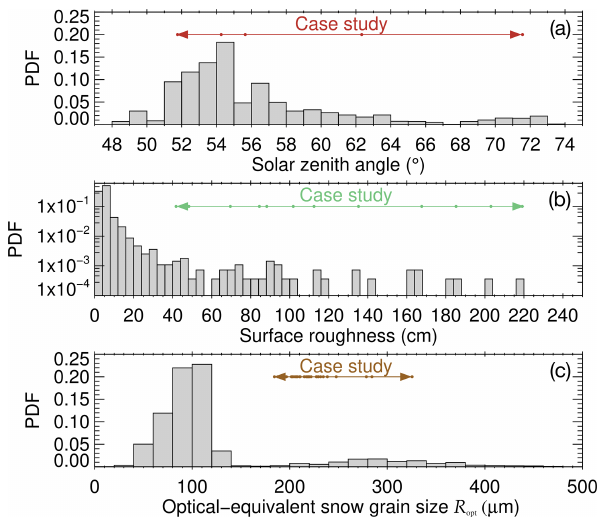
Figure 2. Variability of different parameters during research flights shown as histograms of the probability density function (PDF). The parameter ranges covered by the case studies are marked with the same colors as the corresponding flight tracks in Fig. 1. (a) Vari- ability of solar zenith angle (bin size: 1 ◦ ). (b) Variability of surface roughness (bin size: 4cm). Note the logarithmic scale. (c) Variabil- ity of optical-equivalent snow grain size (bin size: